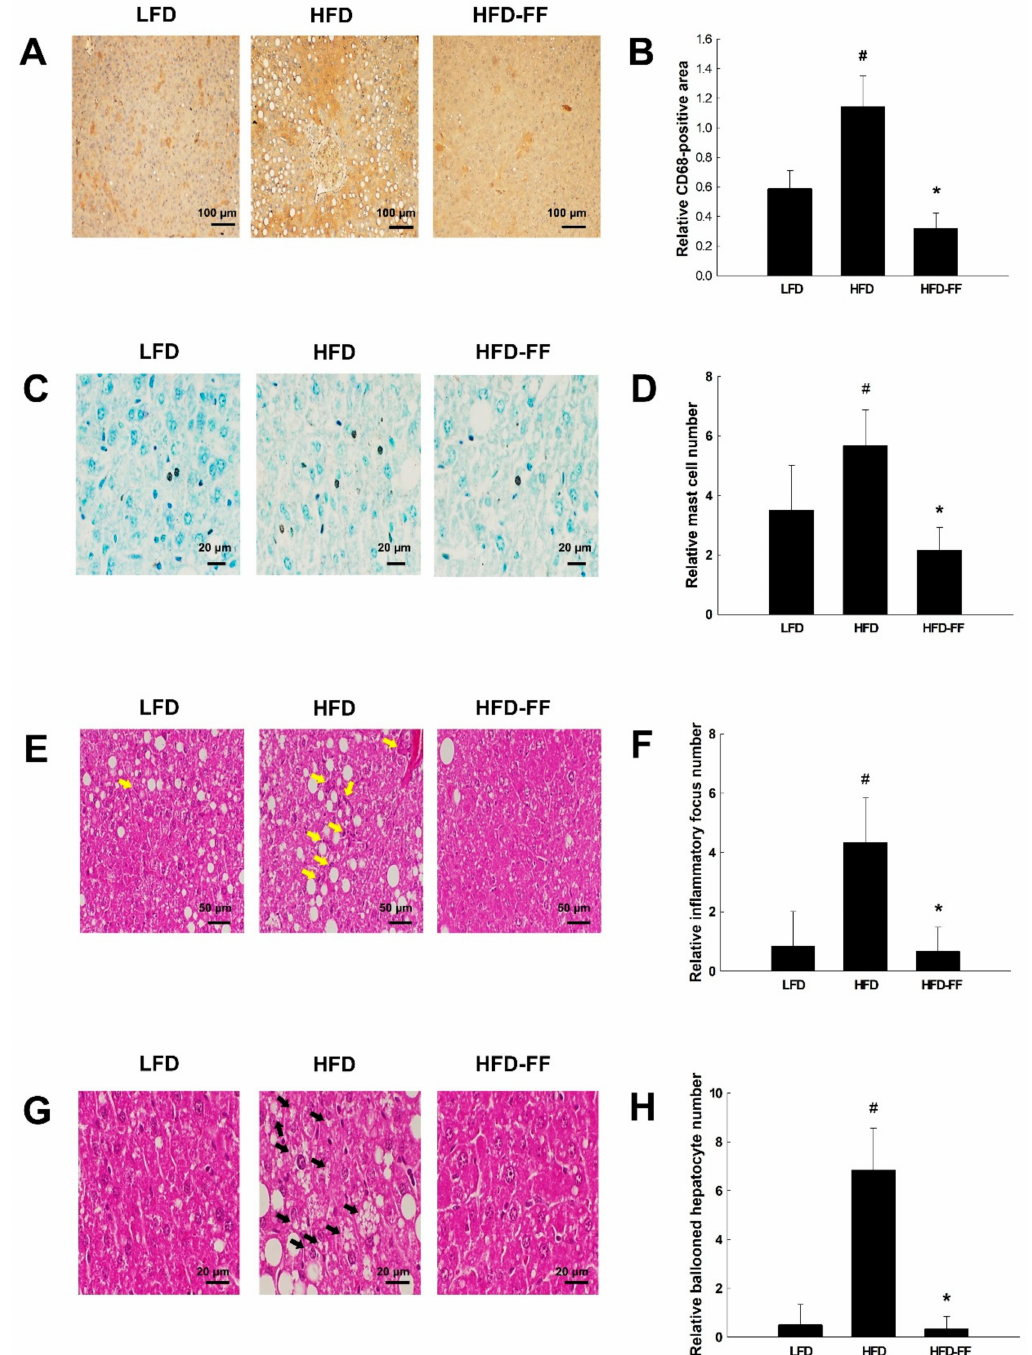
Figure 4. Effects of fenofibrate on hepatic inflammation and hepatocyte ballooning in HFD-fed female OVX mice. OVX C57BL/6J mice were fed an LFD, an HFD or an HFD supplemented with fenofibrate (HFD-FF, 0.05% w / w ) for 21 weeks. ( A ) Immunohistochemical detection of CD68-positive macrophages in liver tissues (original magnification × 200). ( B ) Rel- ative CD68-positive area in liver tissues. ( C ) Toluidine blue-stained sections of liver tissues (original magnification, × 400). ( D ) Relative mast cell number. ( E ) Hematoxylin-eosin-stained necroinflammatory focus of liver sections (original magnification × 100). Necroinflammatory foci are indicated by yellow arrows. ( F ) Relative inflammatory focus number. ( G ) Hematoxylin-eosin-stained ballooned hepatocytes in liver sections (original magnification × 100). Ballooned hepatocytes are indicated by black arrows. ( H ) Relative ballooned hepatocyte number. All values are expressed as mean ± SD ( n = 8 per group). # p < 0.05 compared with LFD, * p < 0.05 compared with